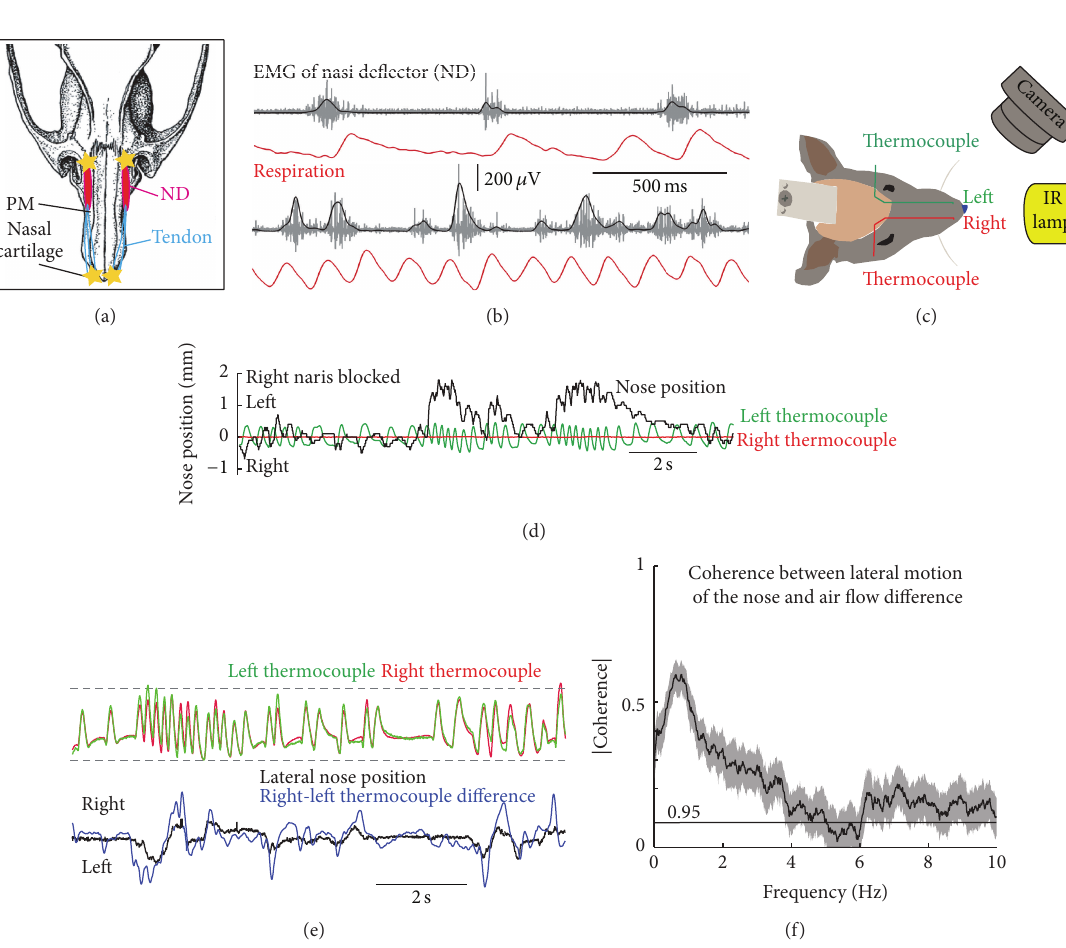
Figure 5: Facial motoneurons and nose motion. (a) Muscle nasi deflector (ND) is located laterally to the premaxillary bone (PM). It takes origin at the orbital edge of the maxilla and its long tendon inserts over the nasal cartilage (stars, attachment sites). (b) Electromyographic recordings in alert head-restrained rats reveal that muscle ND is active during the late phase of expiration during basal respiration (upper traces) and during the early phase of expiration during sniffing (lower traces); black traces, smoothed rectified EMGs. (c) Experimental setup to measure nose motion and nasal airflow in head-restrained rats; IR, infrared light. (d) Blockade of the right naris with a polymer compound abolishes respiratory signals from the right thermocouple and biases nose deflection towards the left side of the face. (e) Upper traces show normalized respiratory signals recorded from the left and right nostrils. Lower traces show that change in lateral nose position is associated with change in airflow through the left and right nostrils as estimated from difference in the amplitude of thermocouple signals. (f) Spectral coherence between lateral displacement of the nose and air flow difference between the left and right nostrils. Black line, 95% confidence level based on Gaussian approximation; light red area, 95% confidence interval based on boot-strap. All data in this figure are unpublished